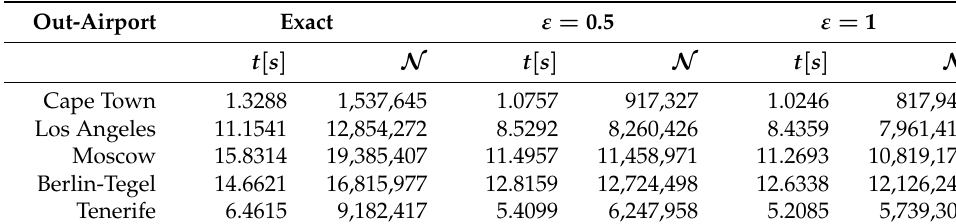
Table 5. Running times and computed permanent labels on FPP instances.